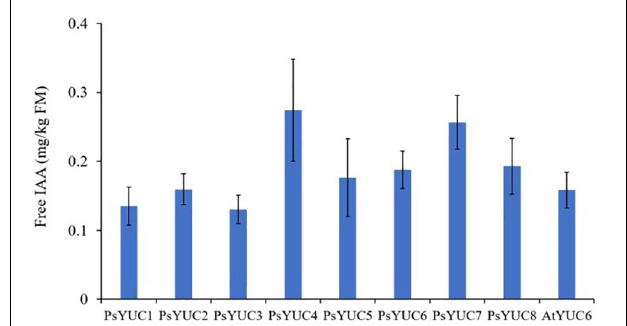
FIGURE 3 | Free IAA production by N. benthamiana leaves above background levels following co-infiltration of AtTAA1, AtTAR2 and one of nine YUC genes. In each case, bars show the mean ± SEM, n = 4. The accumulation of free IAA in control plants infiltrated only with empty vector was below quantifiable levels so it is not shown in the